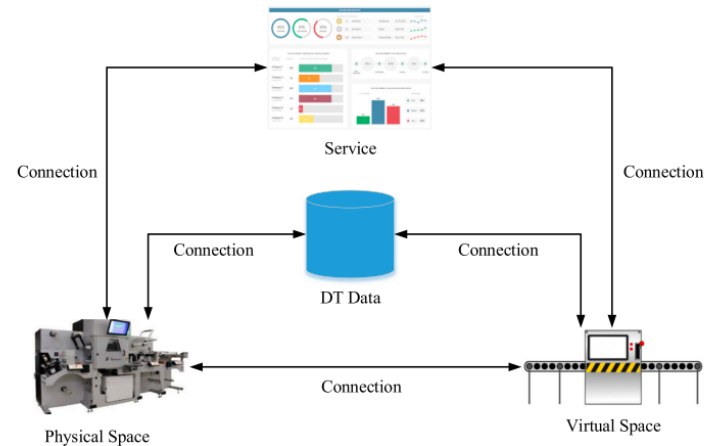
Figure 14. Five elements of a DT [105,106].